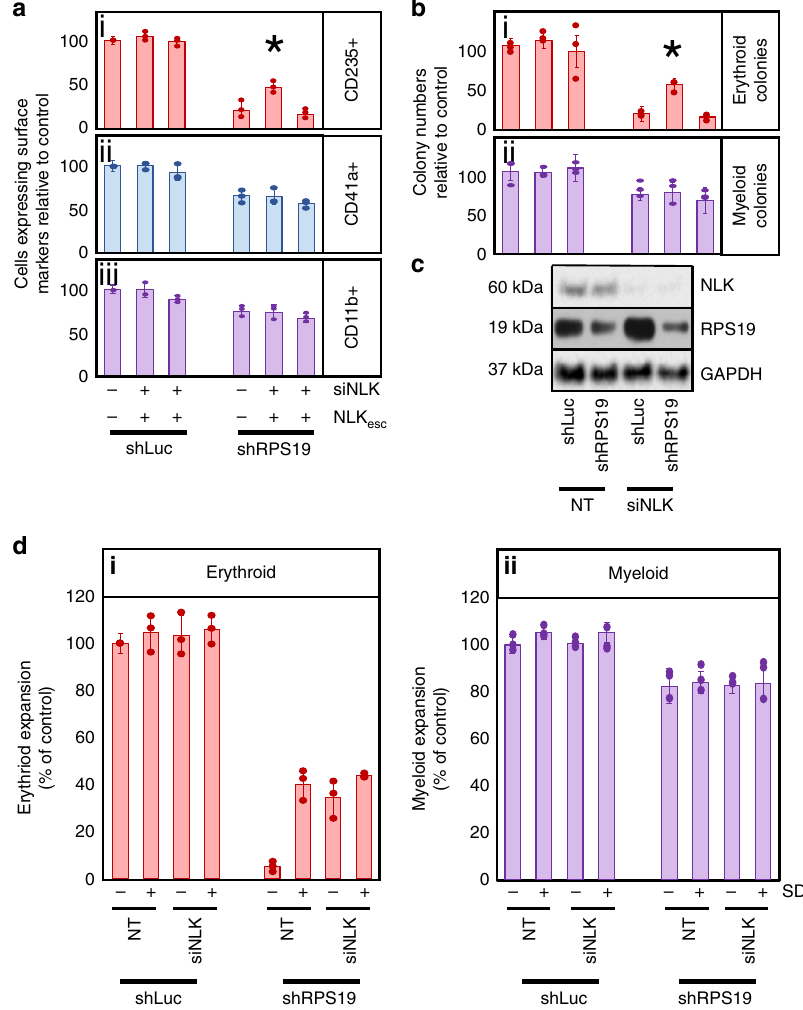
Fig. 2 NLK expression contributes to erythroid defects in RPS19-insuf fi ciency. a Cord blood CD34 + progenitors were transduced with lentivirus expressing shRNA against luciferase (shLuc) or RPS19 (shRPS19) co-expressing GFP, along with siRNA targeting NLK (siNLK) co-expressing RFP and a siNLK-resistant NLK (NLK esc ) co-expressing puromycin resistance. GFP + RFP + progenitors were differentiated in erythroid media for 15 days prior to counting and assessment for surface expression of (i) CD235 (erythroid), (ii) CD41a (megakaryocyte) and (iii) CD11b (myeloid) cellular markers by fl ow cytometry. Within each sample, the total number of cells was multiplied by the percentage of cells expressing each differentiation marker and values were normalized and expressed as a percentage of control (shLuc/NT). b Transduced GFP + ,RFP + cord blood CD34 + progenitors were differentiated in methylcellulose for 12 – 15 days and colonies were scored as either erythroid (i) or myeloid (ii). c Expression of NLK, RPS19, and GAPDH were analyzed by Western blot analysis after 5 days of differentiation. d CD34 + progenitors were transduced with shRNA against luciferase or RPS19 and non-targeting or siRNA against NLK. After sorting, samples were split into two groups and either treated with vehicle or SD208 every three days. After 15 days cells were counted and subject to fl ow cytometry to compare the expansion of maturing CD235 + erythroid (i) and CD11b + myeloid cells (ii). Bars represent means ± SD with individual data points overlaid. n = 3 independent experiments performed in triplicate. Statistics: two-tailed Student ’ s t test, signi fi cant * p < 0.05. Also see Supplementary Fig. 2. Erythroid expansion is depicted in red, megakaryocyte in blue and myeloid in purple. Source data are provided as a Source Data fi